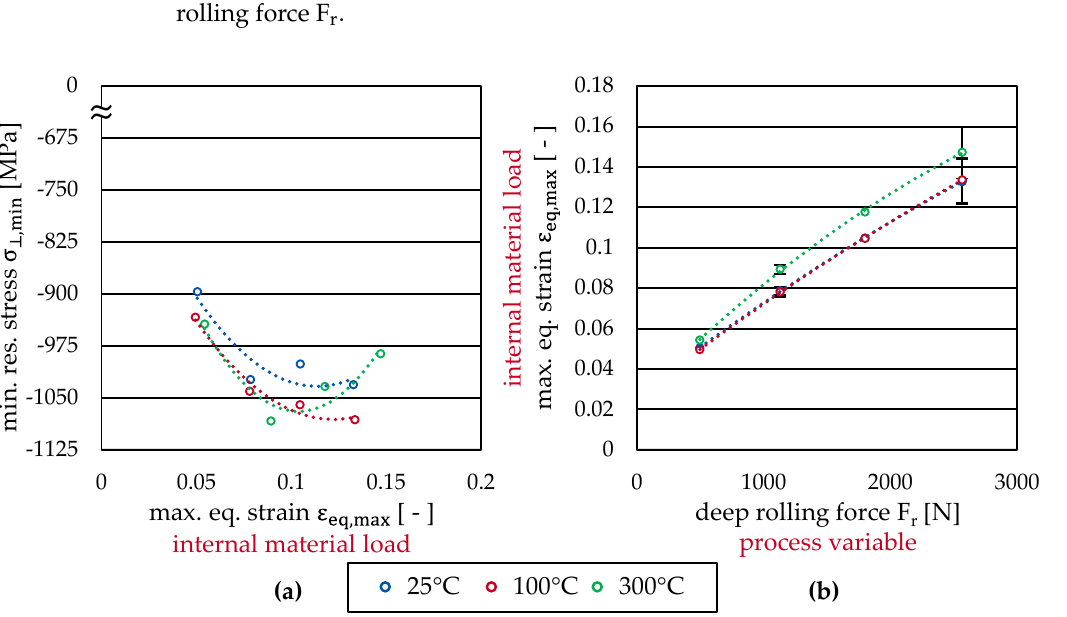
Figure 18. ( a ) Correlation of maximal perpendicular residual compressive stress (material modification) and maximal equivalent strain (internal material load) and ( b ) correlation of maximal equivalent strain with the deep rolling force at different temperature levels during deep rolling.